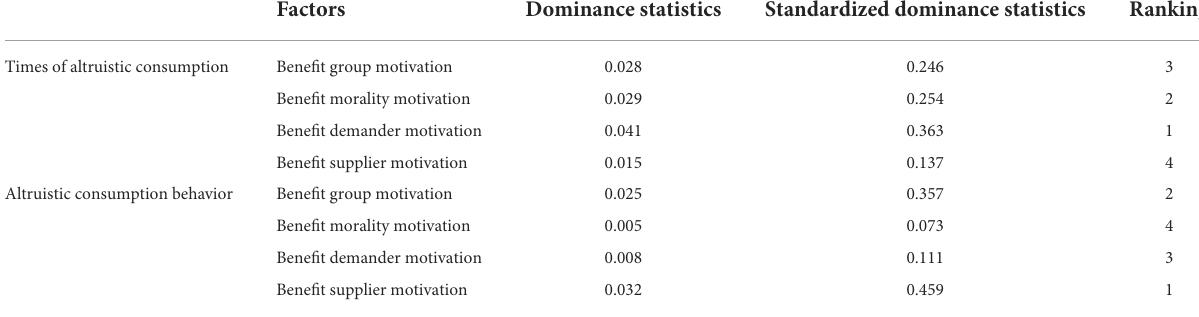
TABLE 5 Dominance analysis.